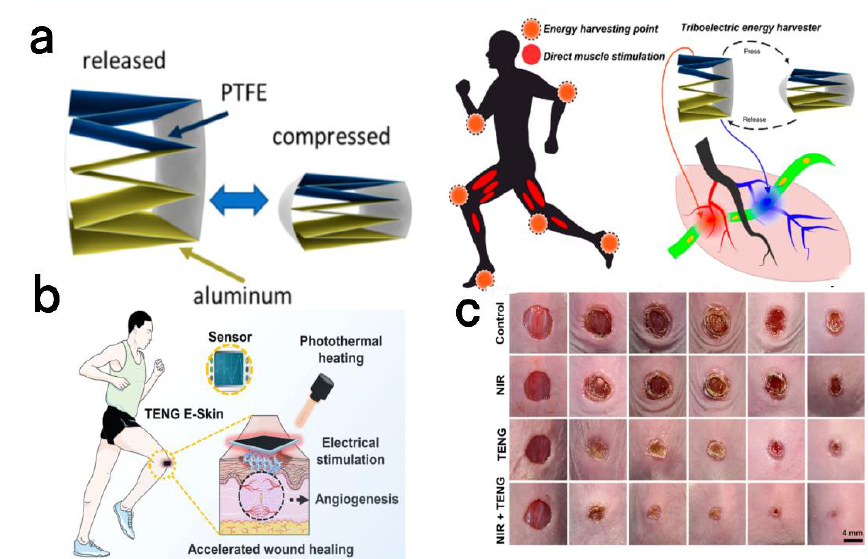
Figure 13. ( a ) The left half shows the tensile and compressive properties of the TENG, and the right half shows the concept of muscle electrical stimulation directly powered by the TENG [90]. Wang et al. (2019), ACS. ( b ) Functions of wearable TENG e-skin patch in the wound: near-infrared photothermal heating, electrical stimulation, and sense. ( c ) Skin wound images were taken on days 0, 3, 5, 7, 9, and 11 of the control group, NIR, TENG, and NIR + TENG [91]. Du et al. (2022), Elsevier.